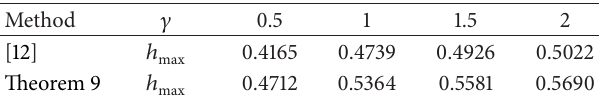
Table 2: The maximum allowable upper bound for different 𝛾 11 and = 0.5 . ℎ 𝑑